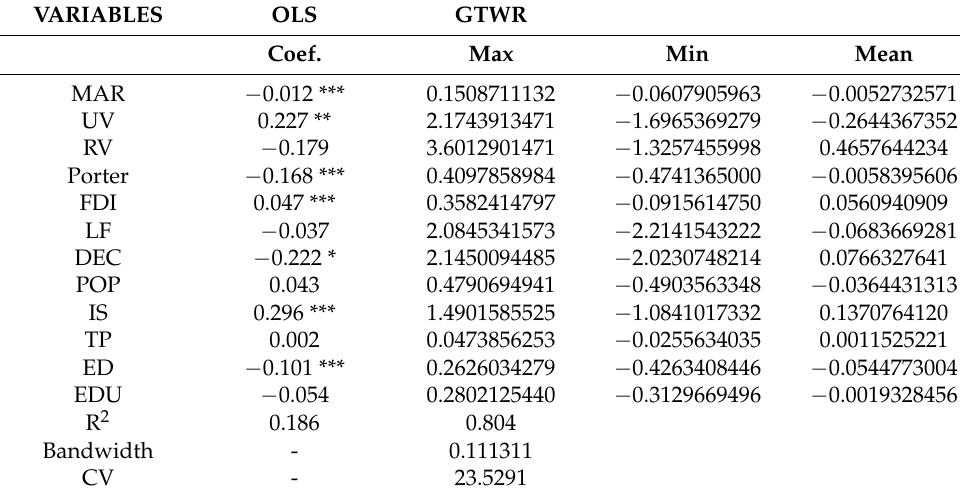
Table 5. Regression coefficient results of each variable of OLS and